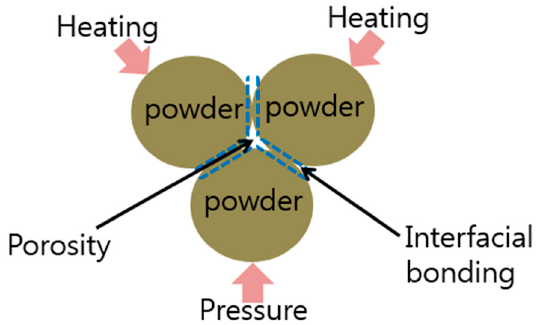
Figure 3. Schematic of sintering process.